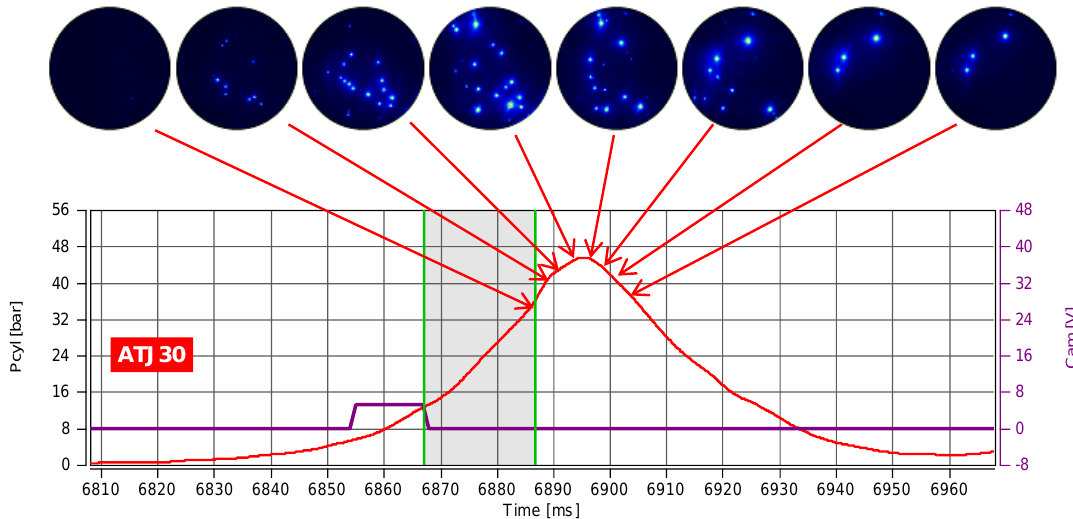
Figure 16. Location of the autoignition spots on the indicator graph during the combustion of the ATJ30 fuel (dt for the images: 2.5 ms).